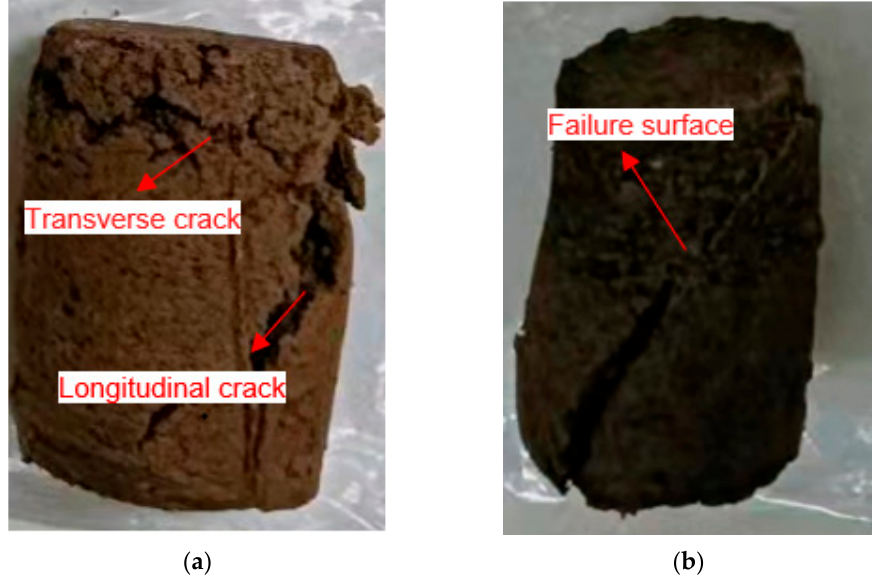
Figure 10. Damage form ⅲ and ⅳ . ( a ) Damage form ⅲ, ( b ) Damage form